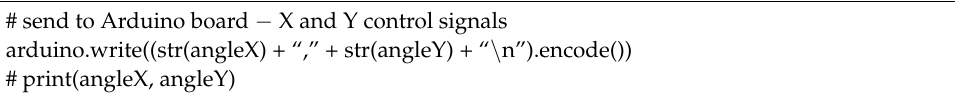
Algorithm 9. Fragment of the Python code: formatted values for the Arduino